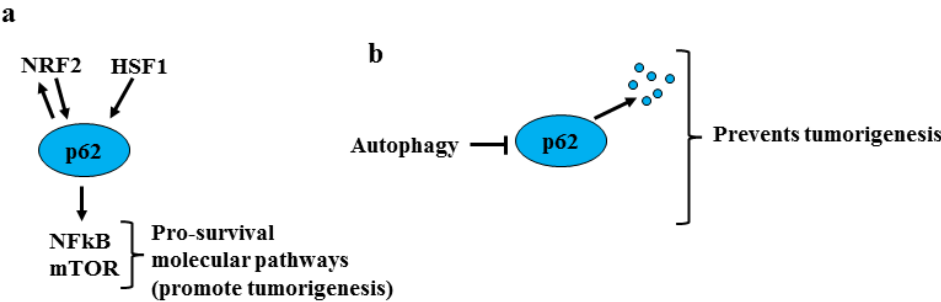
Figure 3. Role of p62/SQSTM1 in tumorigenesis. ( a ) P62/SQSTM1, herein shortened as p62, is a common target of NRF2 and HSF1 activates pro-survival molecular pathways such as NFkB and mTOR that promote tumorigenesis. ( b ) The degradation of p62 by autophagy activation counteracts the first phases of tumorigenesis.